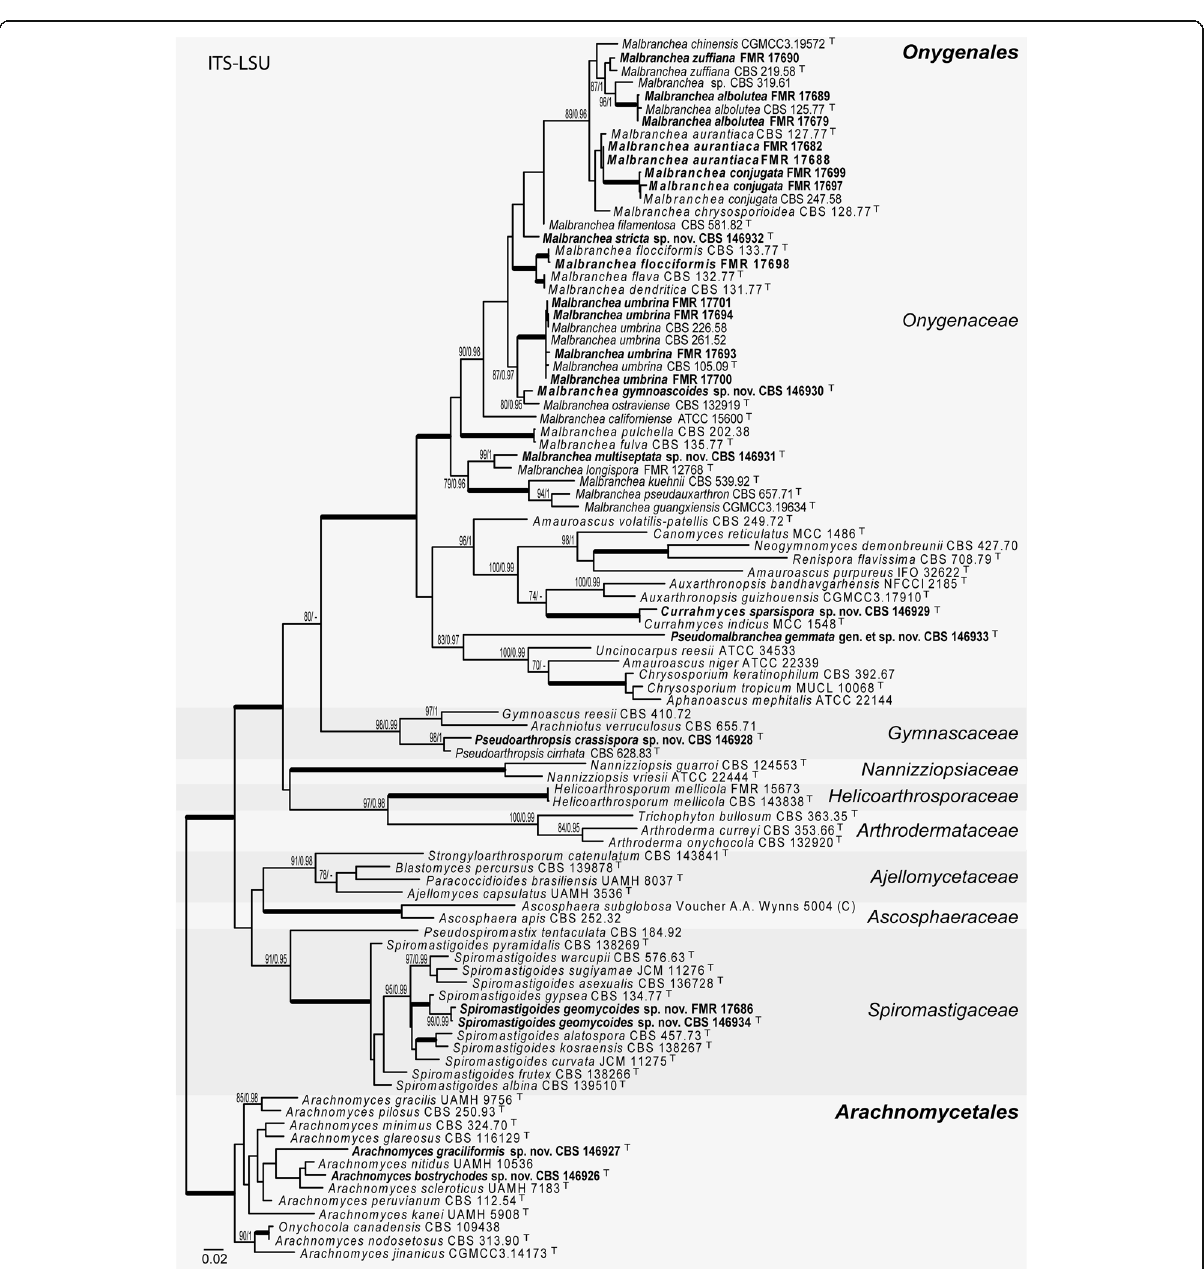
Fig. 2 ML phylogenetic tree based on the analysis of ITS-LSU nucleotide sequences for the 22 clinical fungi from the USA. Bootstrap support values/Bayesian posterior probability scores of 70/0.95 and higher are indicated on the nodes. T = ex type. Fully supported branched (100% BS /1 PP) are indicated in bold. Strains identified by us are in bold. Arachnomyces spp. were chosen as out-group. The sequences used in this analysis are in Table